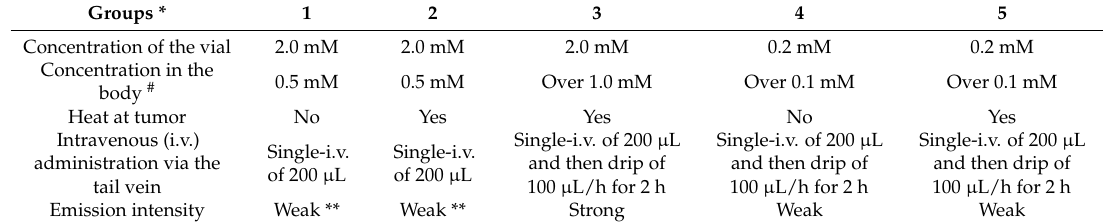
Table 1. Conditions of the treatment groups and the fluorescence imaging results, following the administration of TFMAQ-diEg4.